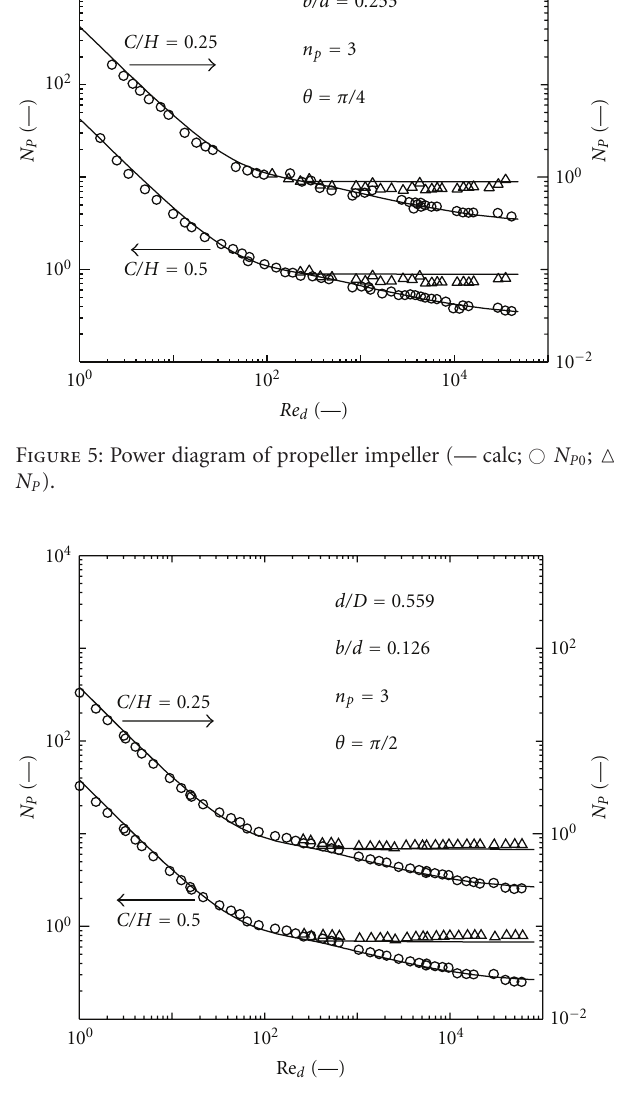
Figure 6: Power diagram of pfaudler-type impeller (— calc; (cid:2) N P 0 ; (cid:2) N P